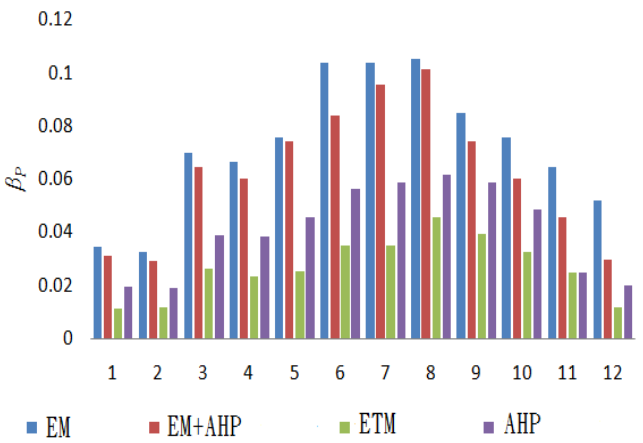
Figure 12. Annual Power Shortage Probability (LOLP).